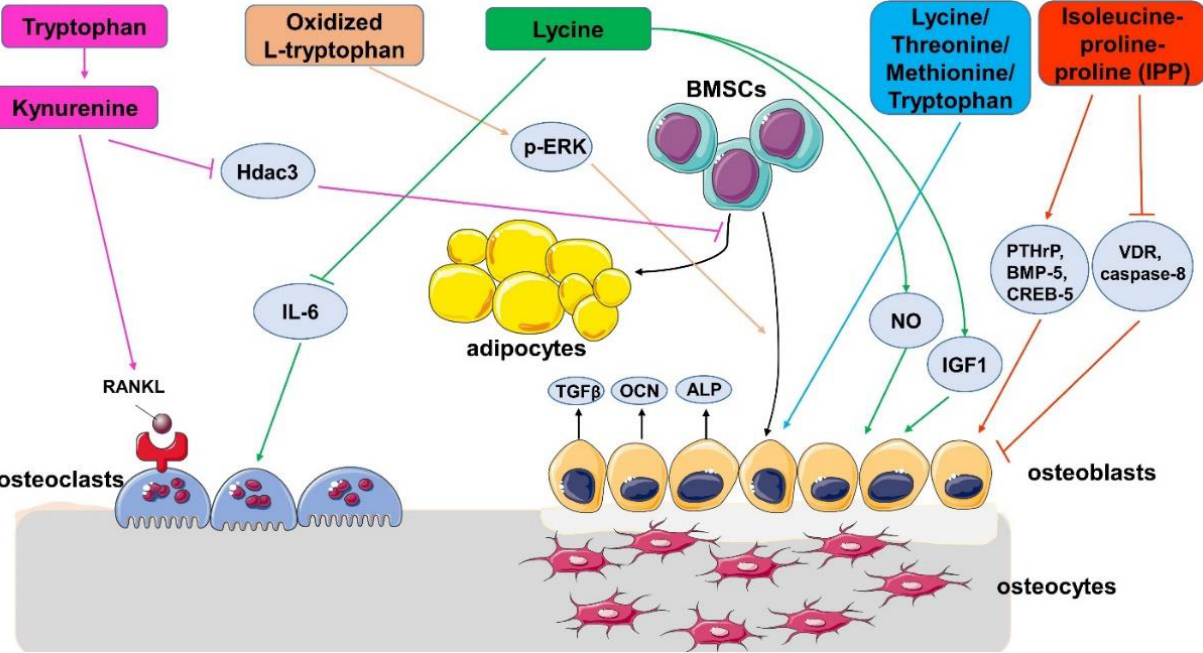
Figure 3. Potential mechanisms of action of essential amino acids in bone metabolism.